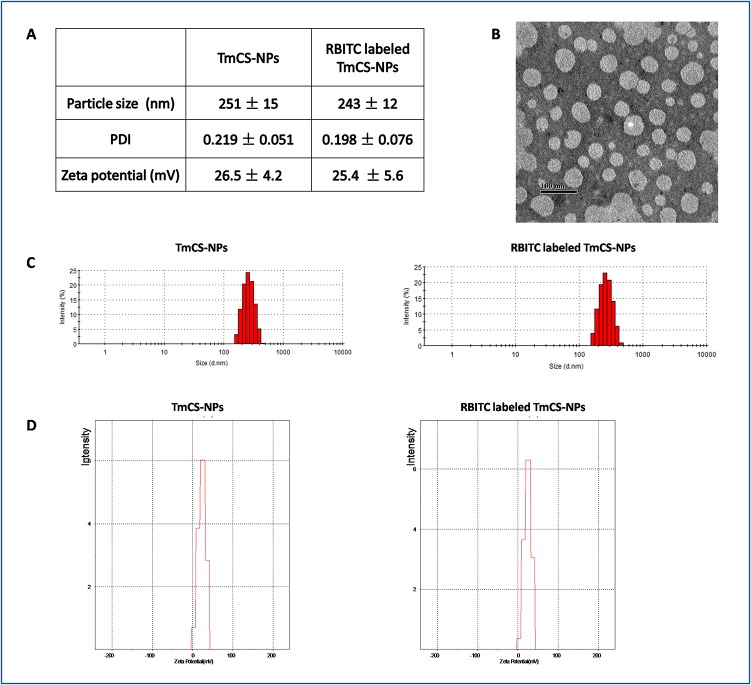
Characterization of unlabeled and RBITC-labeled TmCS-NPs.(A) Particle size, PDI, and zeta potential of the unlabeled and RBITC-labeled TmCS-NPs. (B) TEM analysis of the TmCS-NPs. (C) Particle size graphs of TmCS-NPs and RBITC-labeled TmCS-NPs. (D) Zeta potential graphs of TmCS-NPs and RBITC-labeled TmCS-NPs.